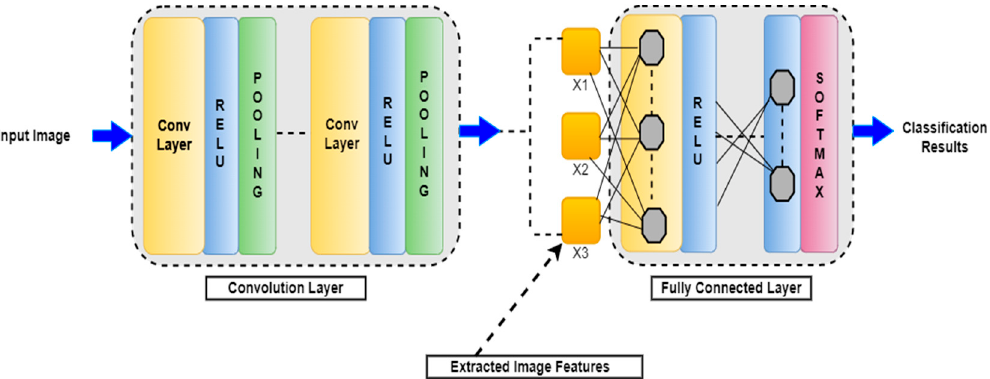
Figure 5. A visual example of the typical structure of CNN.